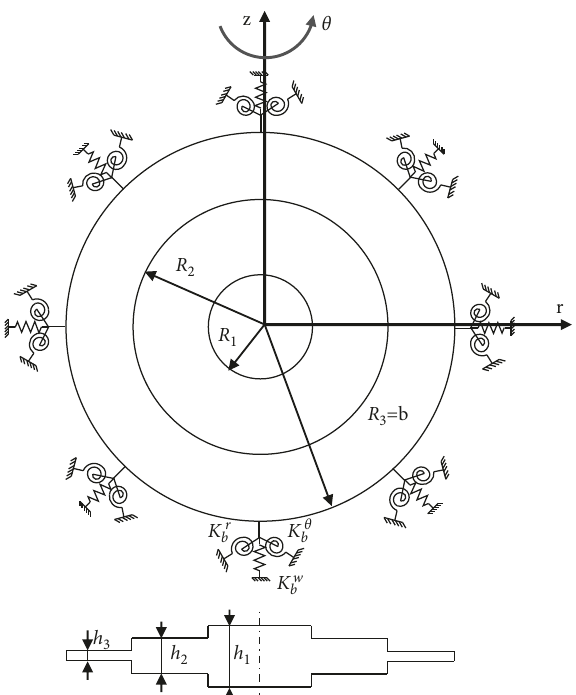
Figure 1: Geometry model and coordinate system for stepped circular Mindlin